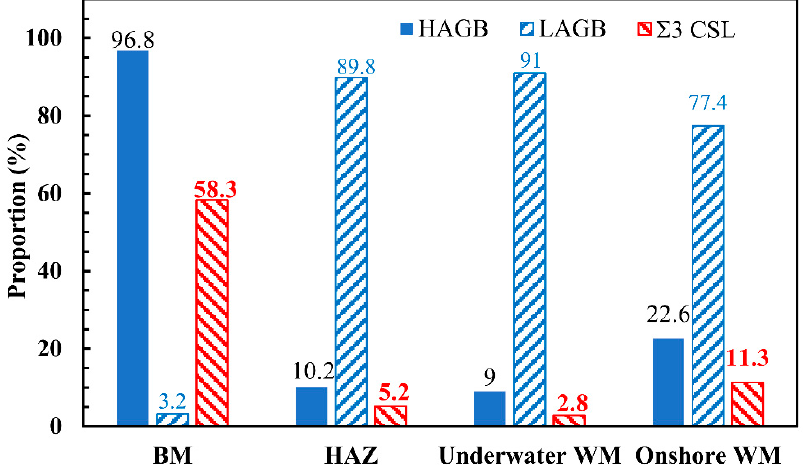
Figure 9. GBMAD of austenite for the ( a ) BM, ( b ) HAZ, ( c ) underwater WM, and ( d ) onshore WM.